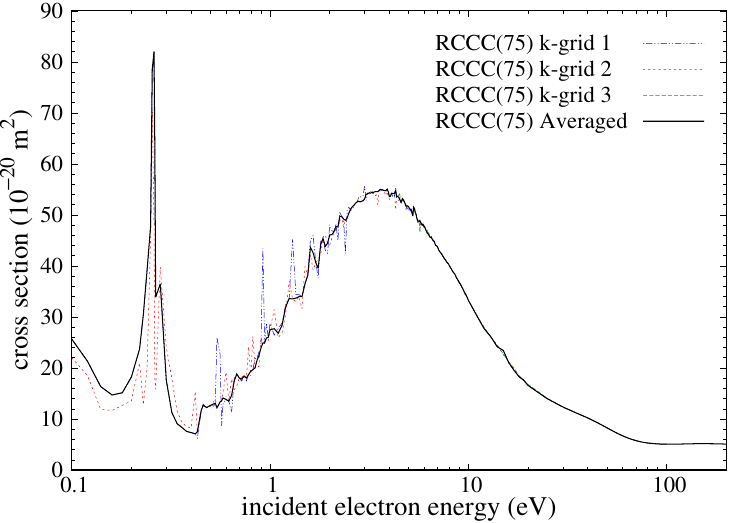
Figure 4. Numerical instability of the RCCC(75) model. Shown for the elastic-scattering cross section for the ground state.